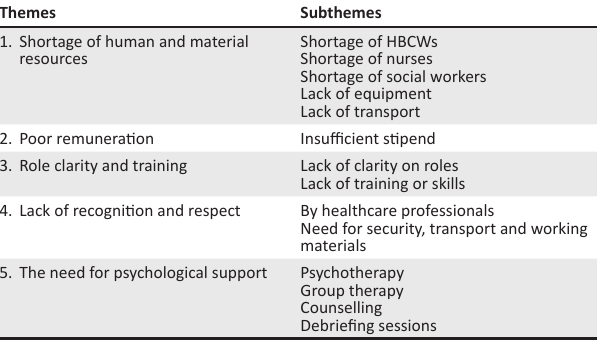
TABLE 1: Summary of themes and subthemes on the experiences of home- based care workers.